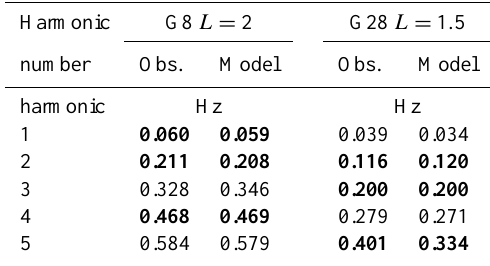
Table 2. The first five harmonics in the spectra for G8 and G28. The model values for the FLR frequencies are obtained from Cummings et al. (1969). The boldface numbers are those frequency estimates that exceed the 95% confidence level in the power